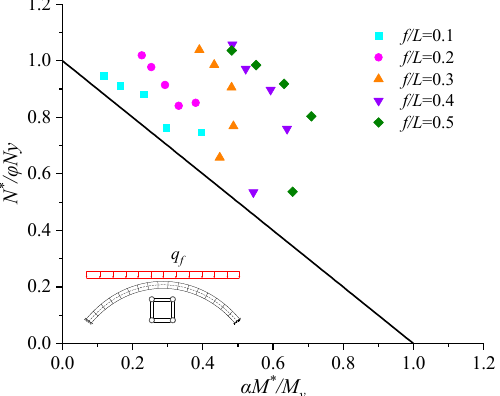
Figure 17. Comparison between the maximum strength pairs and the interaction design curve for the end- fi xed Vierendeel truss arches under FSURLs.